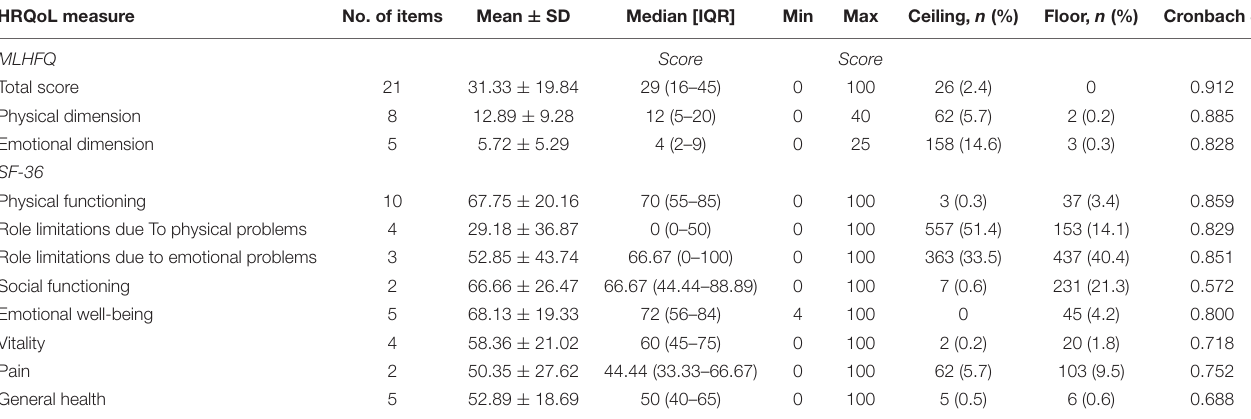
TABLE 2 | Health-related quality of life scales characteristics. HRQoL measure No. of items Mean ± SD